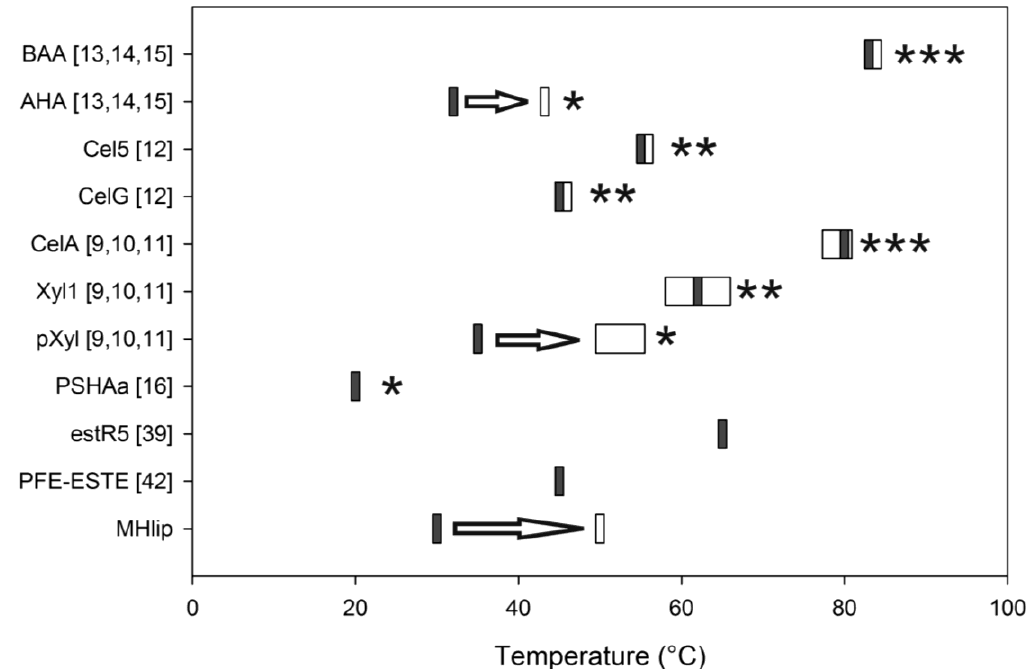
Figure 5. Shift in the observed optimal temperature of activity (gray rectangle) and the melting temperature (Tm, white rectangle) of some characterized proteins. *, ** and *** stand for protein considered psychrophilic, mesophilic and thermophilic in the corresponding references,